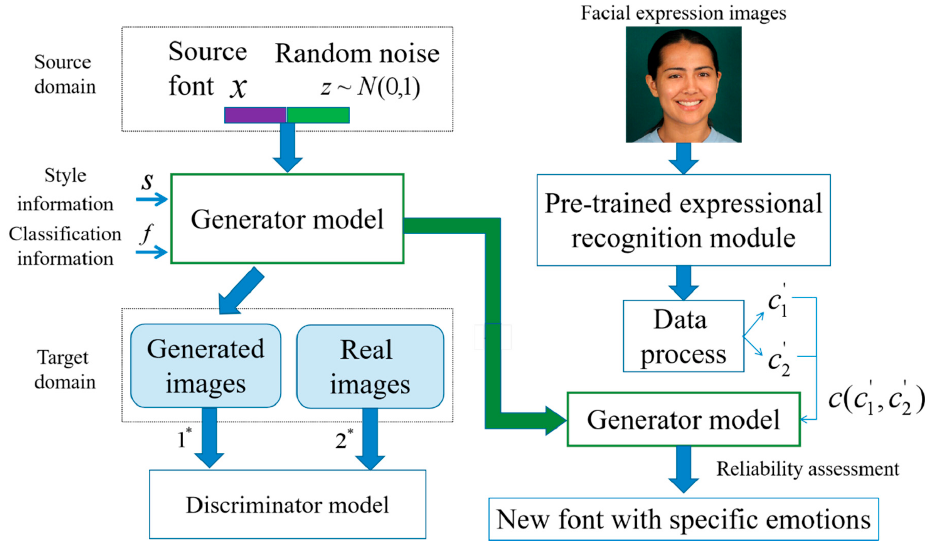
Figure 5. The diagram of the proposed font generation system. 1 * and 2 * imply the learning processes of the discriminator model with {source font image x, generated image} and {source font image x, real image} tuples, respectively. First, the system trains the font generation module until the